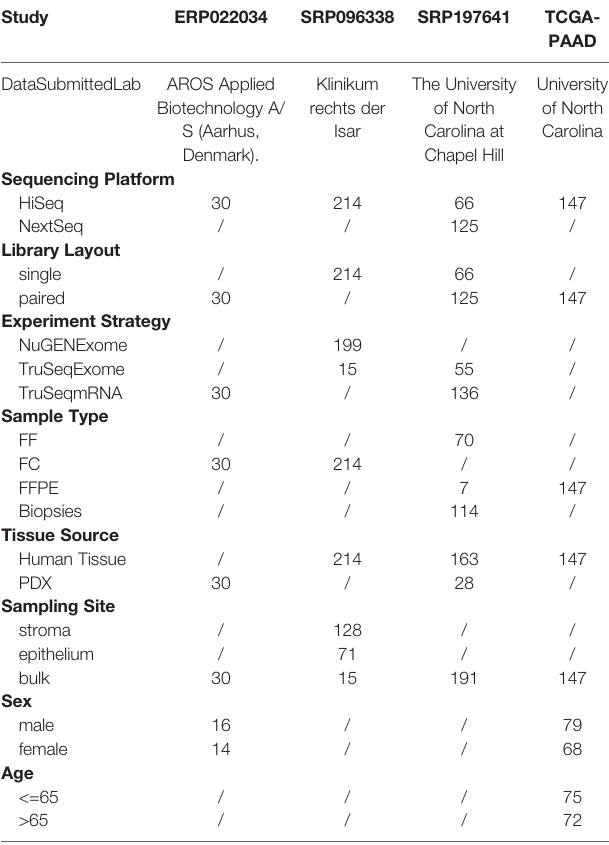
TABLE 1 | An overview of meta information of four PDAC